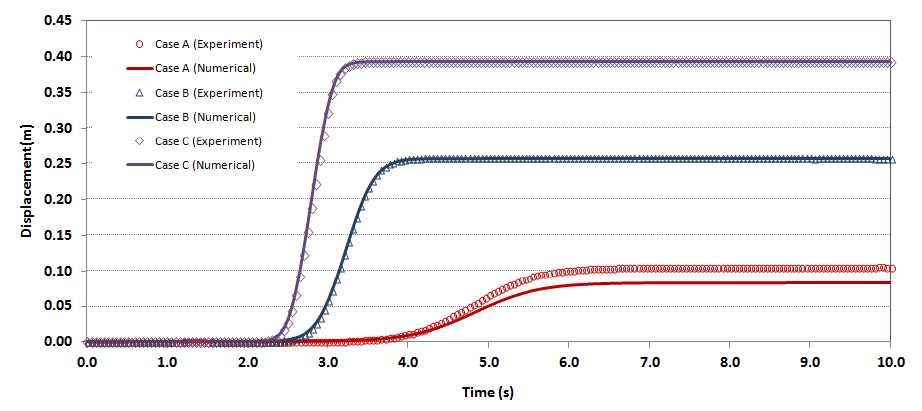
Fig. 2. Paddle trajectory used experiments and numerical simulations of three cases of solitary waves.